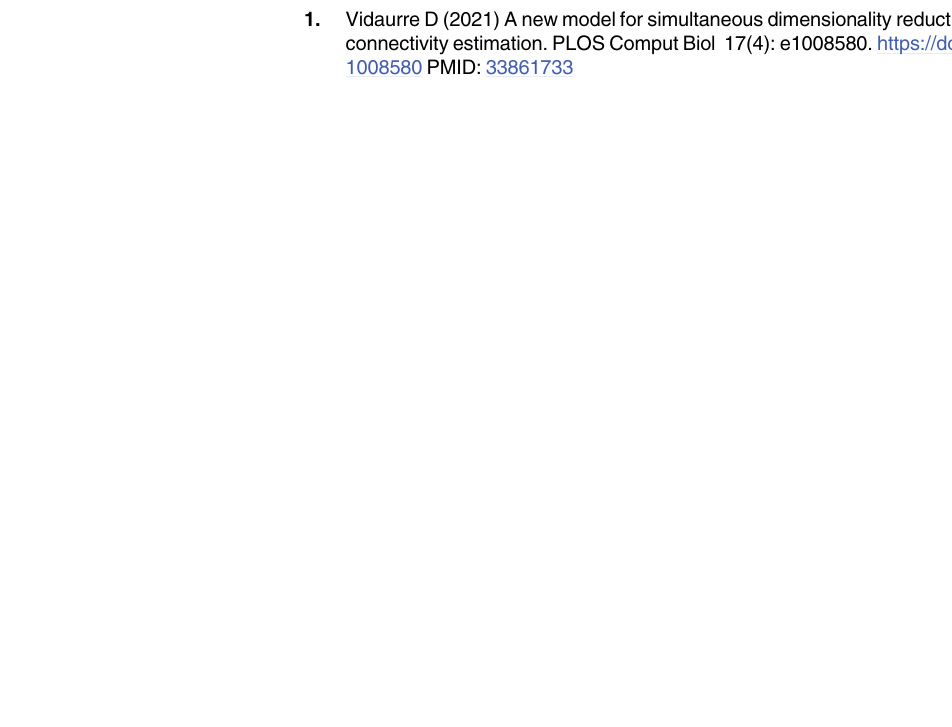
1008580PMID: 33861733